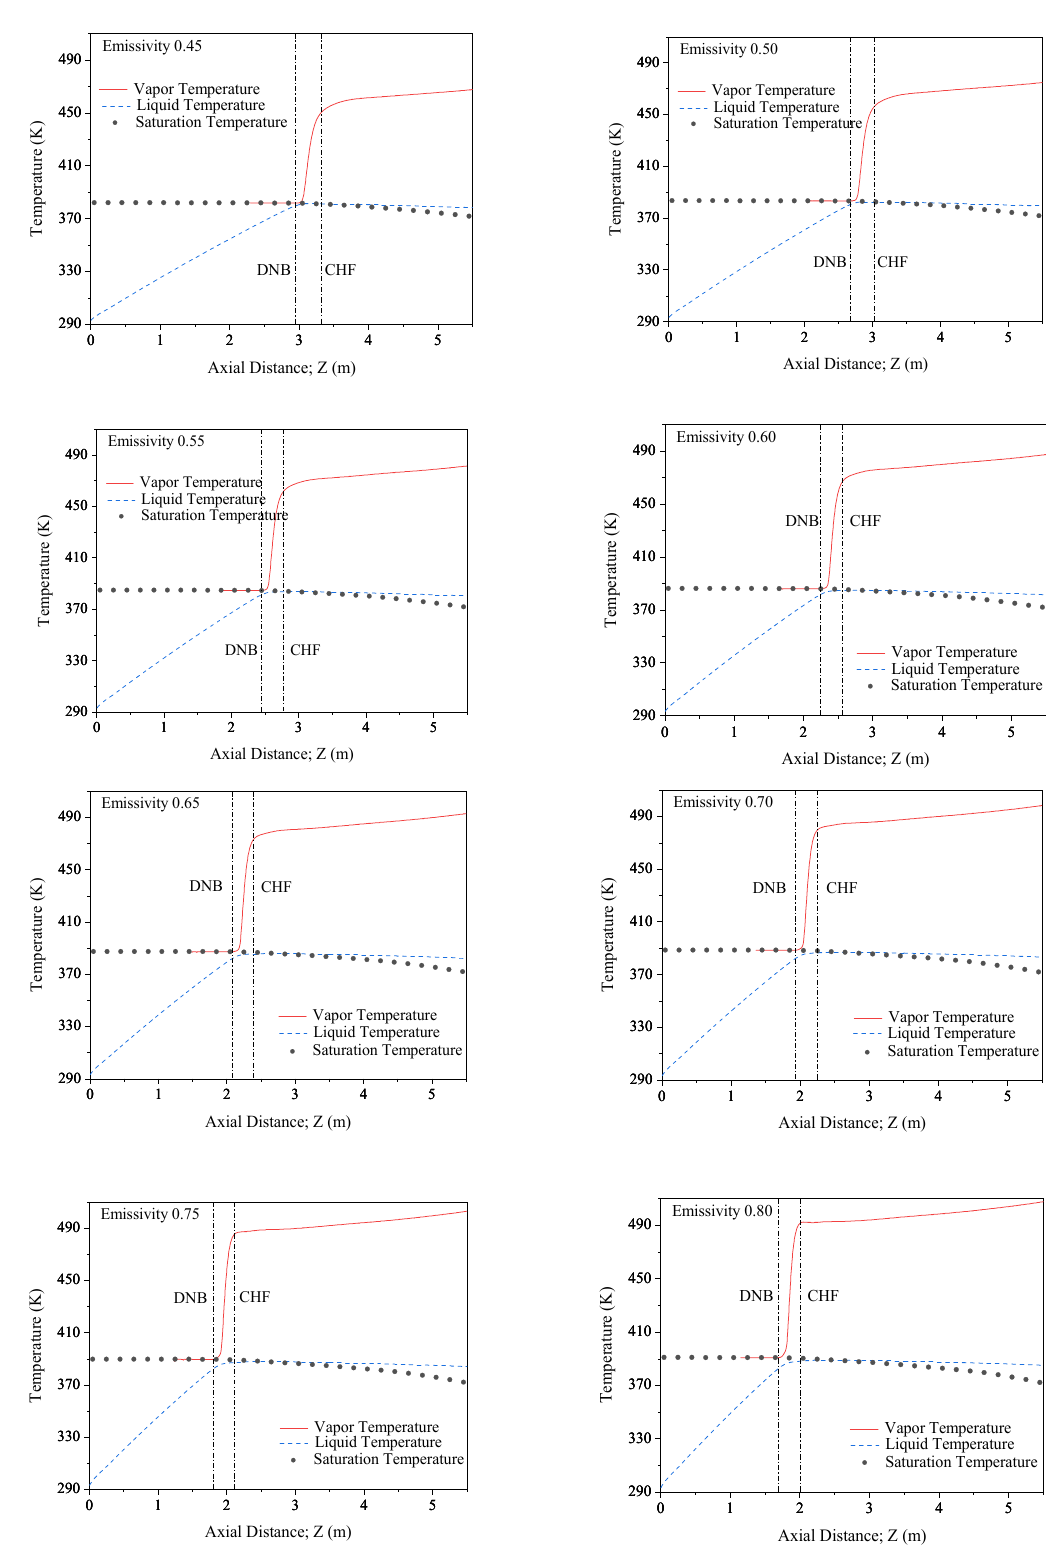
Figure 21. Distributions of average vapor temperature, average liquid temperature and local saturation temperature along the axial direction at inlet velocities ranging from 0.3 m·s − 1 to 0.8 m·s − 1 .